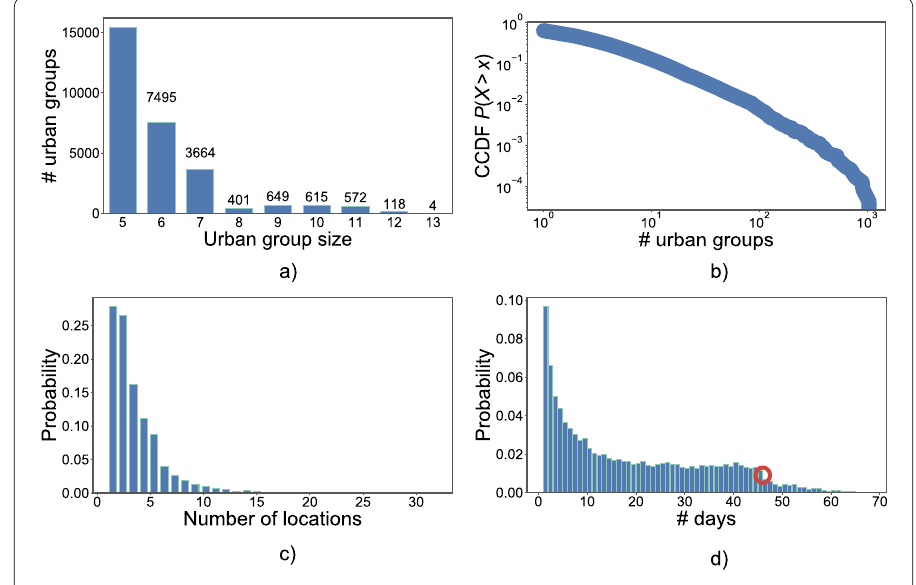
Figure 2 Urban group characteristics. ( a ) The histogram of the urban groups size. ( b ) The distribution of the number of urban groups per user. ( c ) The histogram of number of locations in which an urban group meets up. ( d ) The histogram of the number of days an urban group meets up. The red circle indicates the sharp decrease of the probability after value 46 of the number of days, which corresponds to the number of working days within the observation time